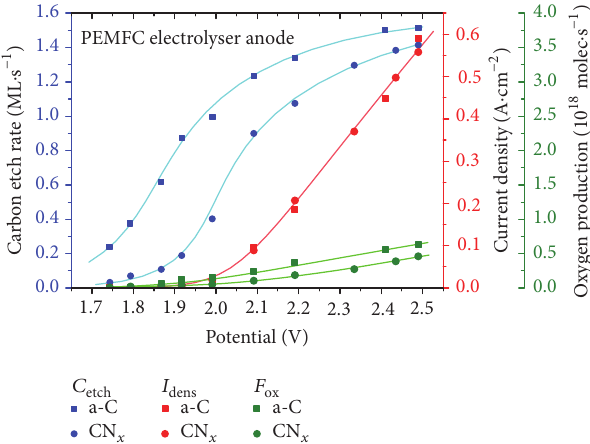
Figure 5: Dependence of carbon etch rate at the FC cathode ( 𝐶 etch , blue), total current density ( 𝐼 dens , red), and oxygen production rate ( 𝐹 O , green) of PEMFC on its potential for Pt catalyst supported on amorphous carbon (squares) and carbon nitride